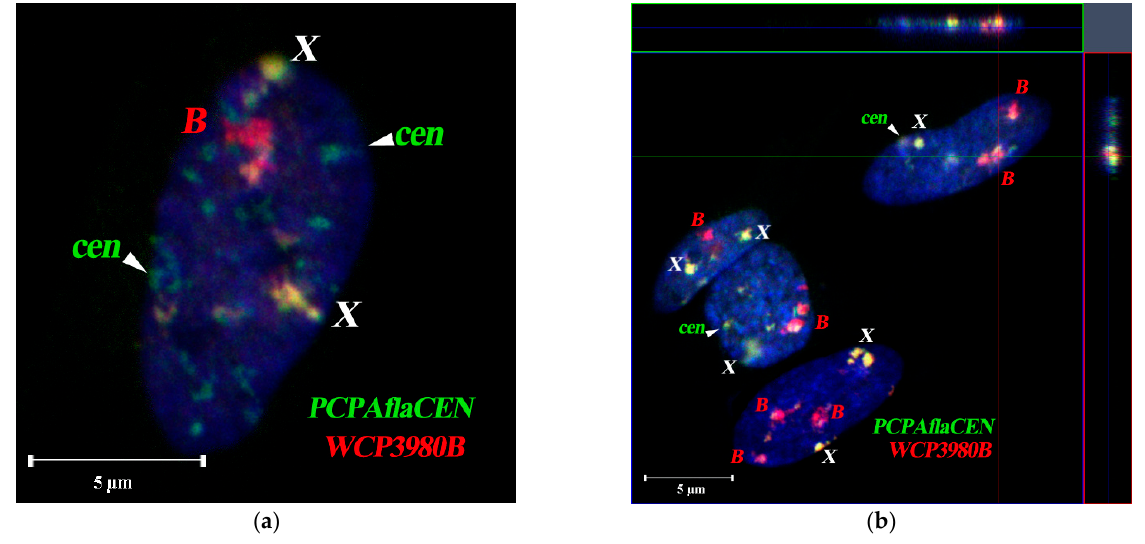
Figure 9. The 3D-FISH of the B-specific probe (WCP3980B, red signal) and the probe to pericentromeric heterochromatin of A-chromosomes (PCPAflaCEN, green signal) in the interphase nuclei of fibroblasts from female #3854 (Misa č a, Serbia) with three Bs. ( a ) Group of fibroblast nuclei; ( b ) orthogonal projection, demonstrating the location of the Bs (red) and pericentromeric heterochromatin regions of As (green). The blue, green and red lines indicate the location of axial, frontal, and sagittal optical sections, respectively. The axial optical section is in the center (xz), the frontal one is on top (xy), the sagittal one is on the right (yz). Co-localization of FISH-signals from B-specific probe and the PCPAflaCEN probe on X chromosomes is revealed as yellow signal. Bs and X chromosomes are marked by corresponding letters; cen—point to autosomal C-positive regions; DAPI staining is blue. Scale bar 5 µm.